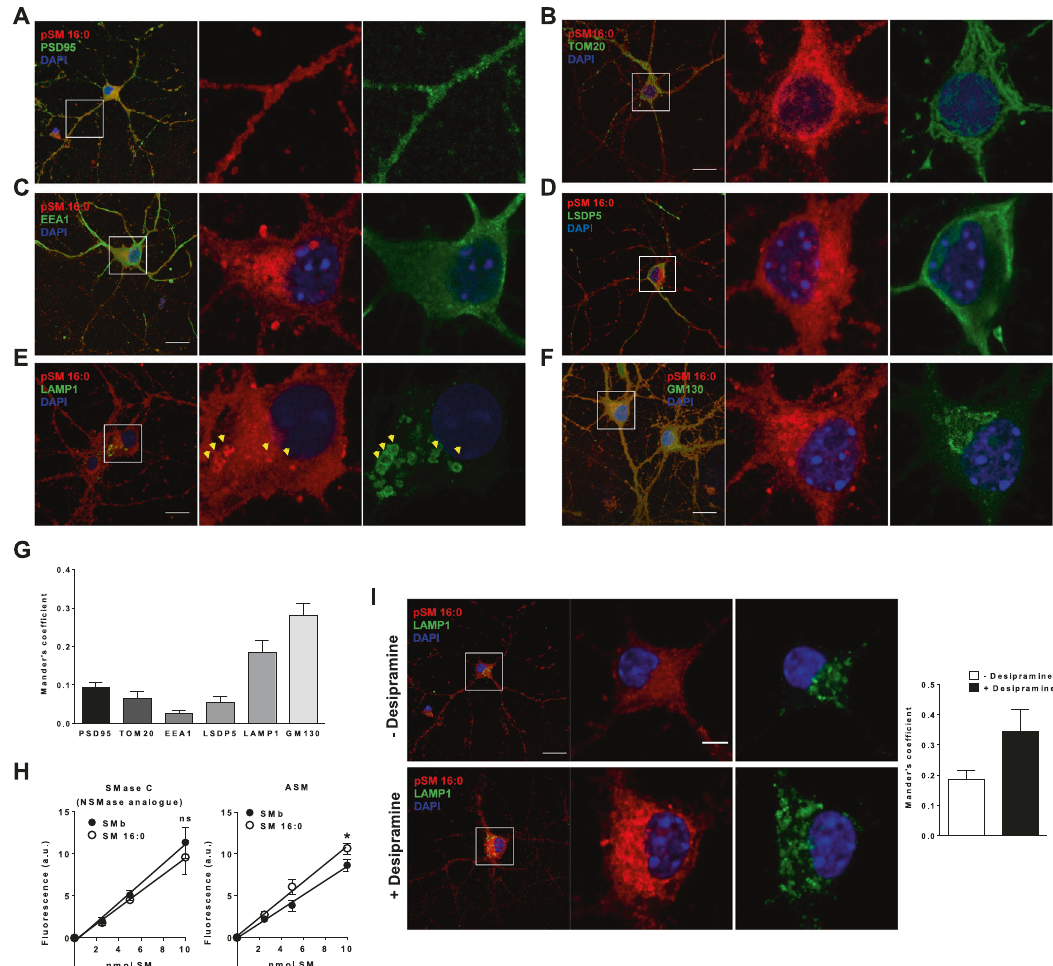
Fig. 3 SM16:0 targets lysosomes in cultured neurons. A Merged low magni fi cation image (left) and single-channel magni fi ed insets (right) of cultured wt neurons incubated with the fl uorescent analogue pSM16:0 co-stained by immunocytochemistry against the postsynaptic density marker PSD95. DAPI staining shows cell nuclei. Bar = 20 µm. Bar (high magni fi cation) = 5 µm. B Merged low magni fi cation image (left) and single-channel magni fi ed insets (right) of cultured wt neurons incubated with the fl uorescent analogue pSM16:0 co-stained by immunocytochemistry against the mitochondrial marker TOM20. DAPI staining shows cell nuclei. Bar = 20 µm. Bar (high magni fi cation) = 5 µm. C Merged low magni fi cation image (left) and single-channel magni fi ed insets (right) of cultured wt neurons incubated with the fl uorescent analogue pSM16:0 co-stained by immunocytochemistry against the early endosomal marker EEA1. DAPI staining shows cell nuclei. Bar = 20 µm. Bar (high magni fi cation) = 5 µm. D Merged low magni fi cation image (left) and single-channel magni fi ed insets (right) of cultured wt neurons incubated with the fl uorescent analogue pSM16:0 co-stained by immunocytochemistry against the lipid droplet marker Perilipin 5 (LSDP5). DAPI staining shows cell nuclei. Bar = 20 µm. Bar (high magni fi cation) = 5 µm. E Merged low magni fi cation image (left) and single-channel magni fi ed insets (right) of cultured wt neurons incubated with the fl uorescent analogue pSM16:0 co-stained by immunocytochemistry against the late endosome-lysosomal marker LAMP1. DAPI staining shows cell nuclei. Bar = 20 µm. Bar (high magni fi cation) = 5 µm. F Merged low magni fi cation image (left) and single-channel magni fi ed insets (right) of cultured wt neurons incubated with the fl uorescent analogue pSM16:0 co-stained by immunocytochemistry against the Golgi marker GM130. DAPI staining shows cell nuclei. Bar = 20 µm. Bar (high magni fi cation) = 5 µm. G Graph shows mean ± SEM Mander´s coef fi cient of colocalization between pSM16:0 and the indicated subcellular markers PSD95, TOM20, EEA1, LSDP5, LAMP1 or GM130 ( n = 3 independent cultures). H Graph shows mean ± SEM levels of fl uorescence in arbitrary units with respect to nmol of SMb or SM16:0 metabolized by Smase C (NSmase analogue) or ASM activity ( n = 3 independent experiments; * p < 0.05). I Images show pSM16:0 colocalization with the lysosomal marker LAMP1 in wt neurons treated or not with the ASM inhibitor desipramine. DAPI staining shows cell nuclei. Graph shows mean ± SEM Mander´s coef fi cient of colocalization between pSM16:0 and LAMP1 ( n = 3 independent cultures).